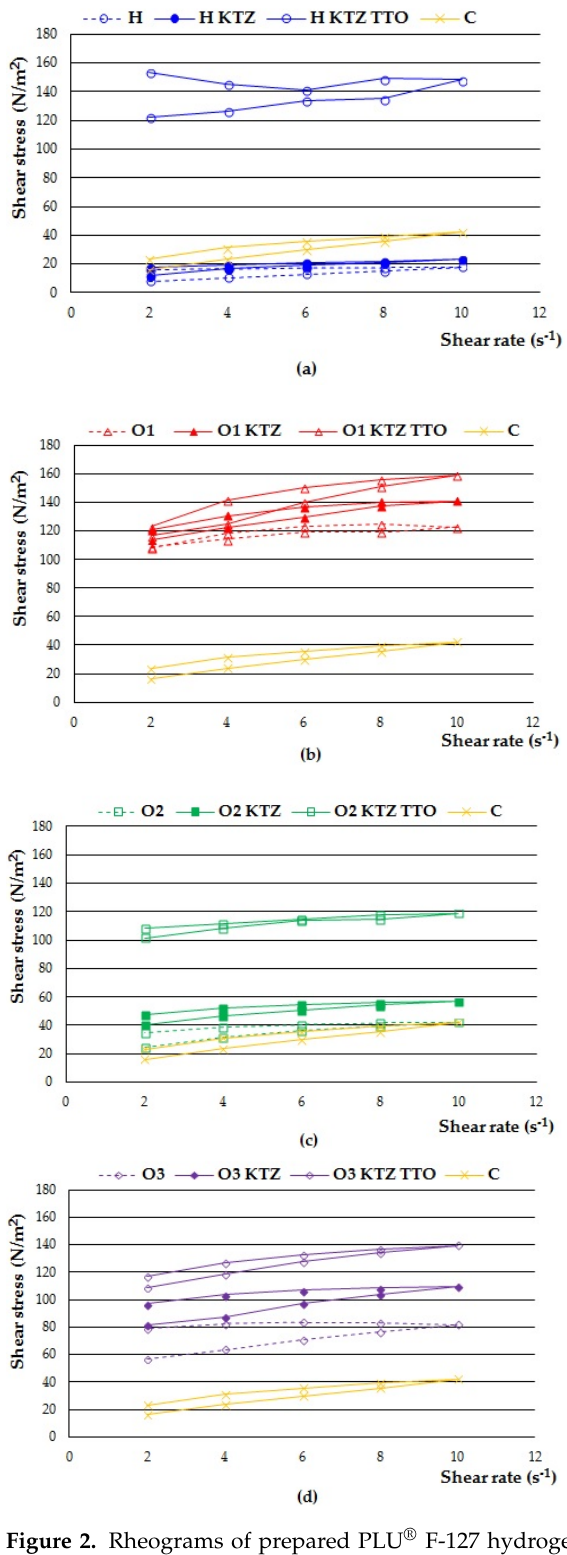
Figure 2. Rheograms of prepared PLU ® F-127 hydrogels: ( a ) H, H KTZ, H KTZ TTO, and PLO organogels; ( b ) O1, O1 KTZ, and O1 KTZ TTO; ( c ) O2, O2 KTZ, and O2 KTZ TTO; and ( d ) O3, O3 KTZ, O3 KTZ TTO, and commercially available product (C).